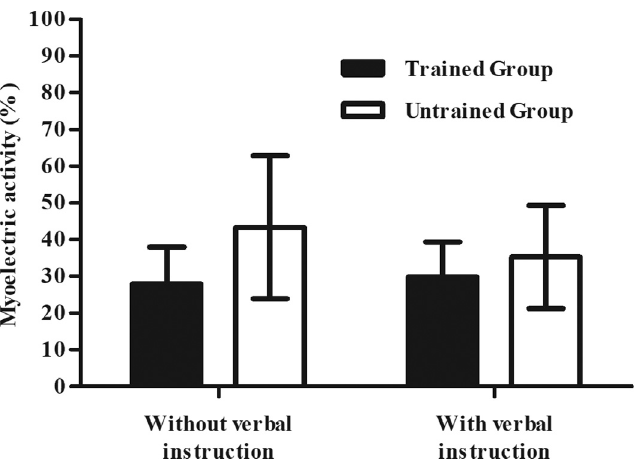
Figure 1 - Myoelectric activity of the latissimus dorsi muscle during the seated row at 70% 1RM with and without verbal instructions in trained and untrained